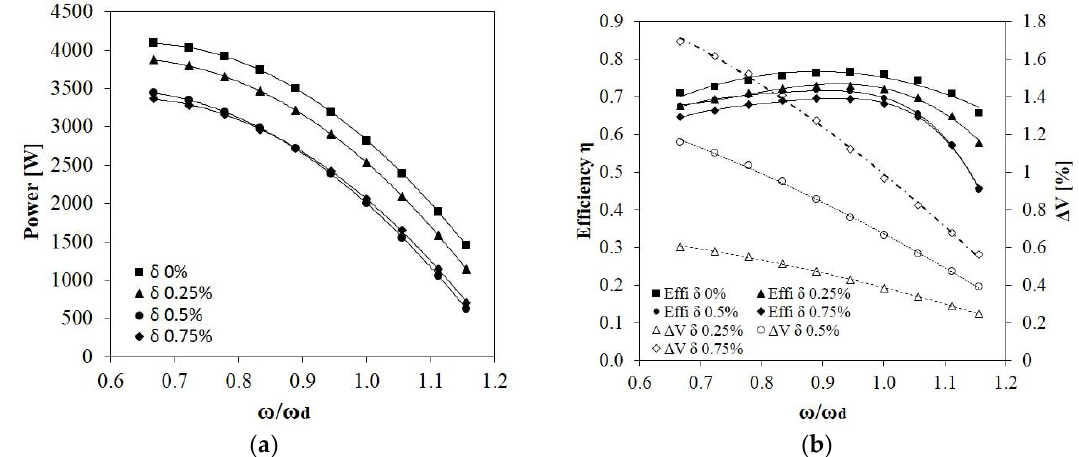
Figure 10. Variation of turbine-characteristic curves for different tip-clearance sizes. ( a ) Power vs. speed; ( b ) leakage volume and efficiency vs. speed.